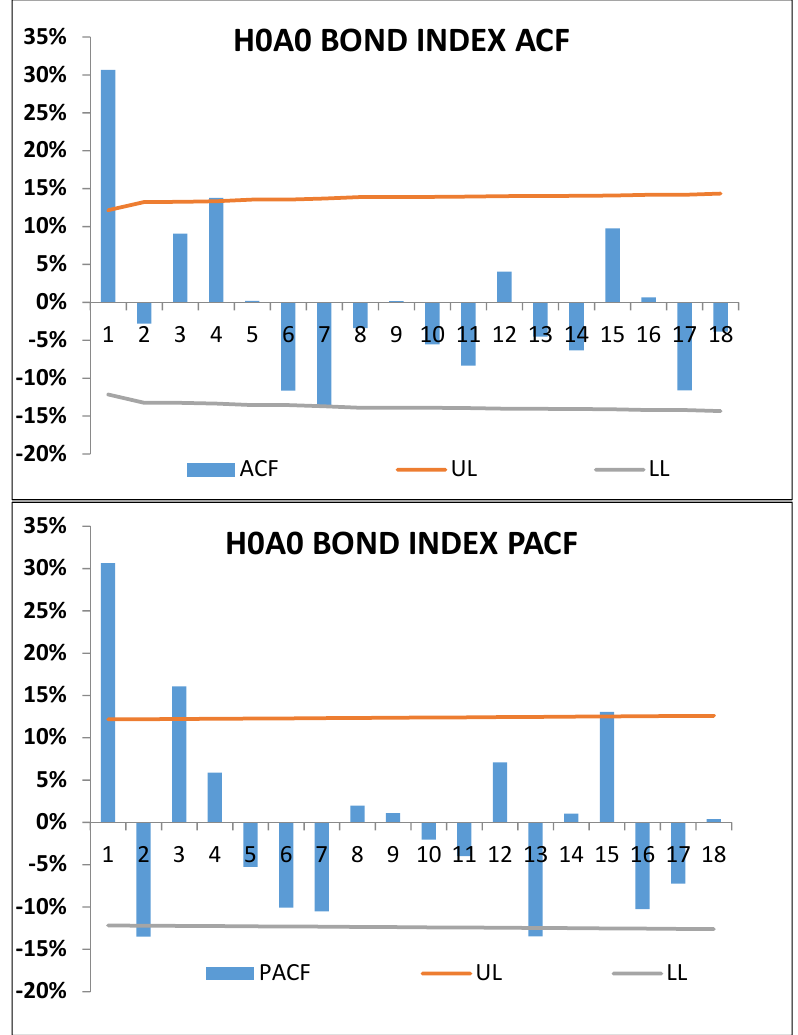
Figure 15. ACF and PACF plot for bonds. Source: authors.